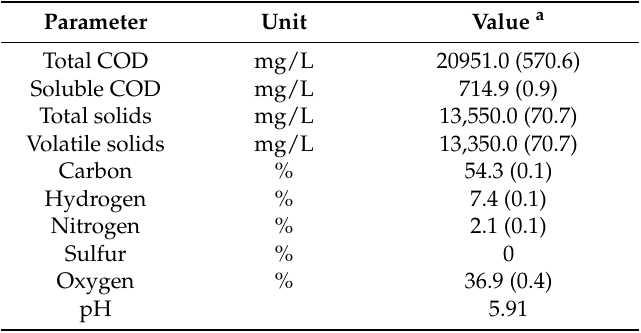
Table 1. Physicochemical characteristics of the spent coffee grounds used in this